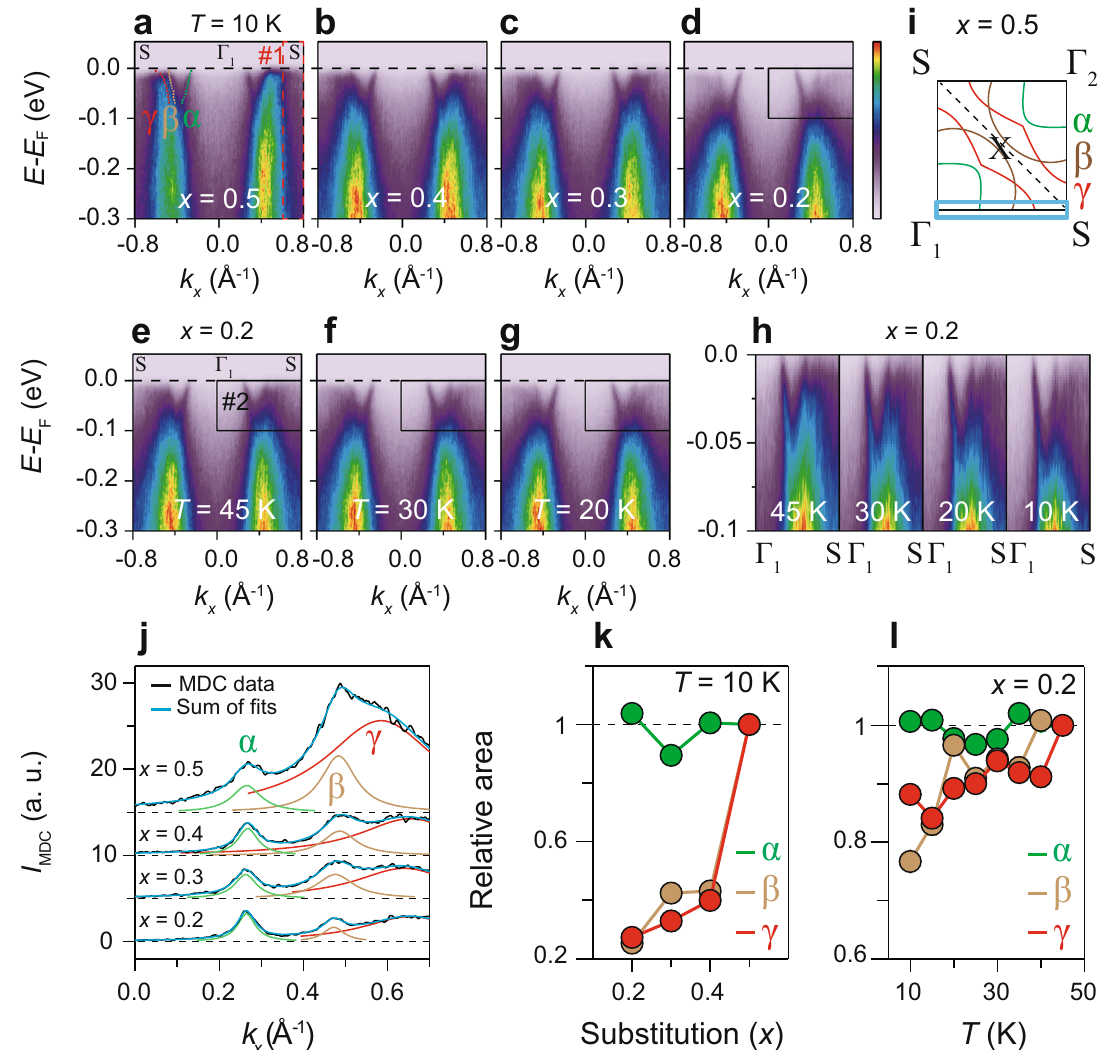
Fig. 2 Substitution- ( x ) and temperature- ( T ) dependent band-selective suppression at E F . ARPES images along S- Γ 1 -S for x = a 0.5, b 0.4, c 0.3, and d 0.2 measured at T = 10 K. ARPES images of x = 0.2 along S- Γ 1 -S measured at T = e 45, f 30, g 20, and d 10 K. h Magni fi ed images of x = 0.2 obtained from region #2 (black rectangles) in d – g measured at T = 45, 30, 20, 10 K; a different colour scale is used to make the T -dependence clearer. Note the soft gap 17,18 opening in the β - and γ -bands. i Schematic Fermi surfaces of α - (green), β - (brown), and γ - (red) bands of x = 0.5. Momentum region for ARPES data in this fi gure is marked with a blue box along Γ 1 -S. j x -dependent normalised MDCs at E F (integrated over E F ± 10 meV) along Γ 1 -S from the data in a – d . The colour-coded curves are the data and corresponding Lorentzian fi ts (black: MDC data, green: α , brown: β , red: γ , blue: sum of fi ts). k The x -dependent changes in Lorentzian fi t areas relative to those of x = 0.5, obtained from j . l T -dependent near E F spectral weight changes relative to that at T = 45 K for x = 0.2 (for the raw data, see Supplementary Fig. 4). All the data were measured with π -polarised light ( hv = 70 eV, Supplementary Fig.